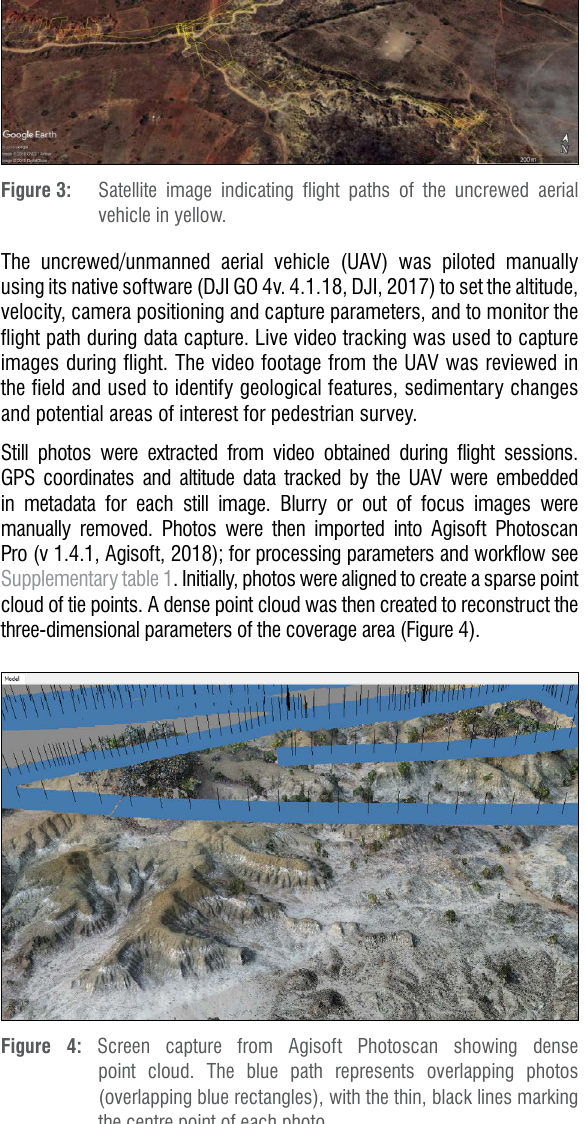
Figure 2: (a) Map showing the location of Isimila within the broader context of East Africa. (b) Map showing Isimila within the Iringa plateau of southern Tanzania. (c) A close-up map of Isimila demonstrating the two primary sections of the Korongo System, labelled ‘northern branch’ and ‘southern branch’, following Howell et al. 4